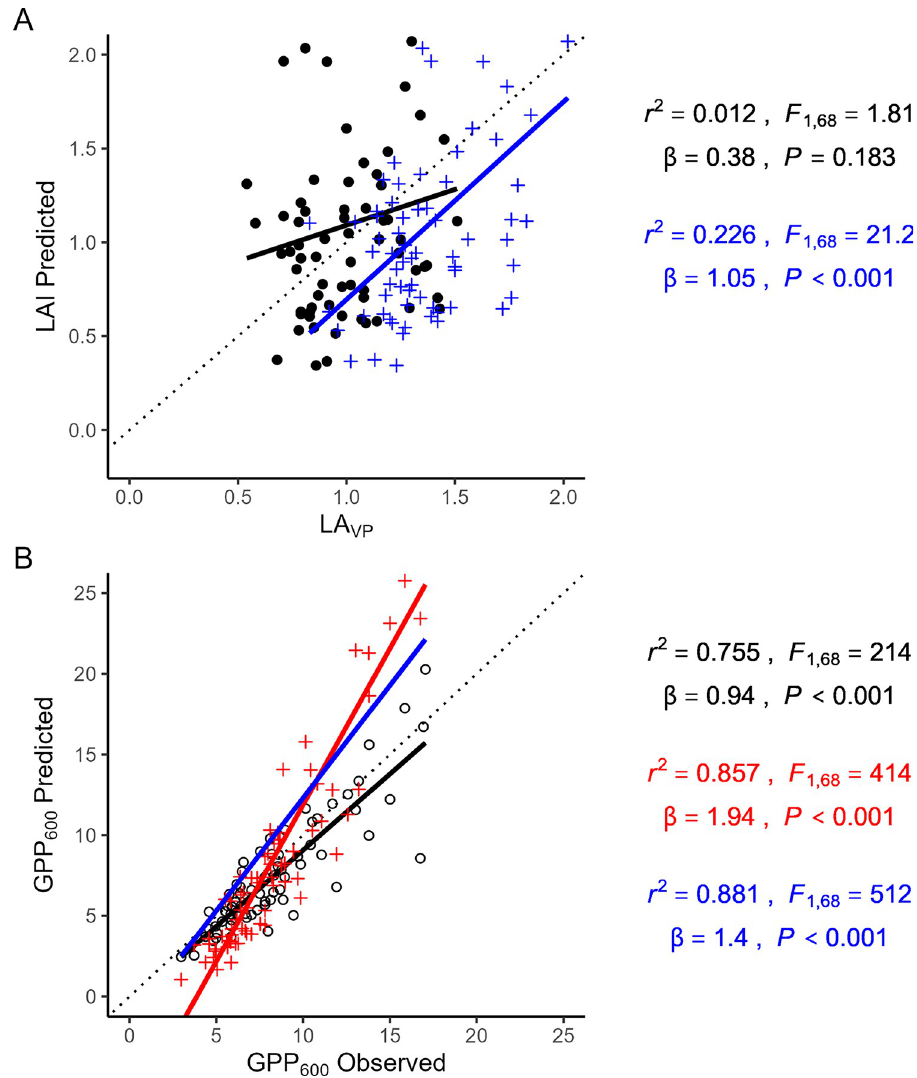
Fig 6. (A) Relationship between LAI predicted using the LAI~NDVI model parameterized with field plot data and observed LA VP . Black points and lines show the fit with LA VP calculated without moss included, whereas the blue line shows the fit with LA VP calculated with moss contributions. (B) Relationship between GPP 600 predicted by the Tundra GPP Model (Eq(5)) using LA VP without moss (black), LA VP with moss (blue), or LAI modeled from NDVI (red) and GPP 600 estimated from field measured light curves. In all plots, the dotted line represents a 1:1